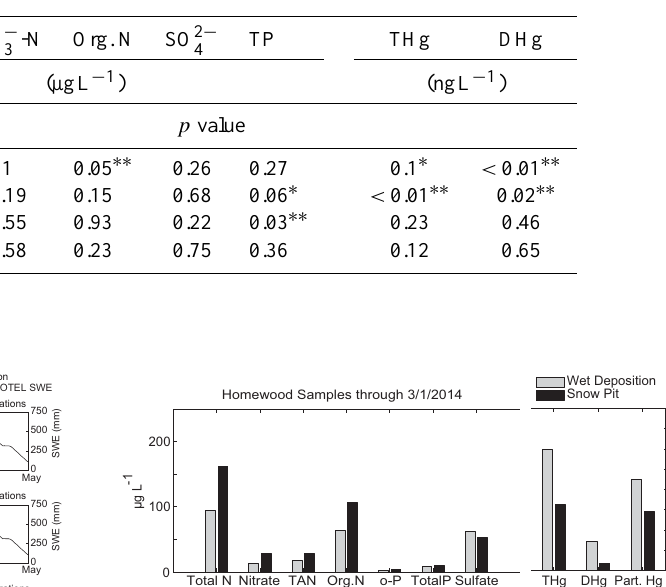
Table 1. Analysis of variance results for 2011–2012 and 2012–2013 snowpack concentrations. Controlling factors of year ( n = 2; 2011–2012, 2012–2013), elevation ( n = 3; high, middle, low), location ( n = 2; east, west), and season ( n = 2; early, late) were investigated.